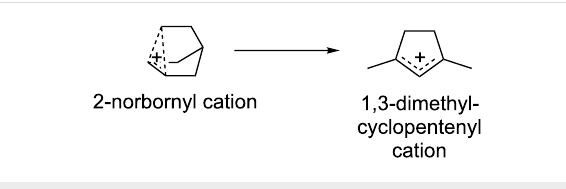
Figure 7: The transformation of 2-norbornyl cation to 1,3-dimethylcy- clopentyl cation.